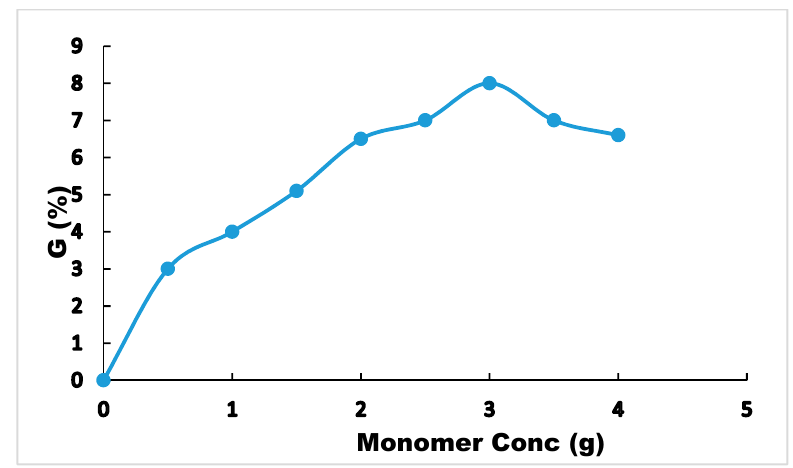
Figure 4. Optimum monomer concentration for microwave synthesis of the Interpenetrating Network Biohar Composite (IPNCB).